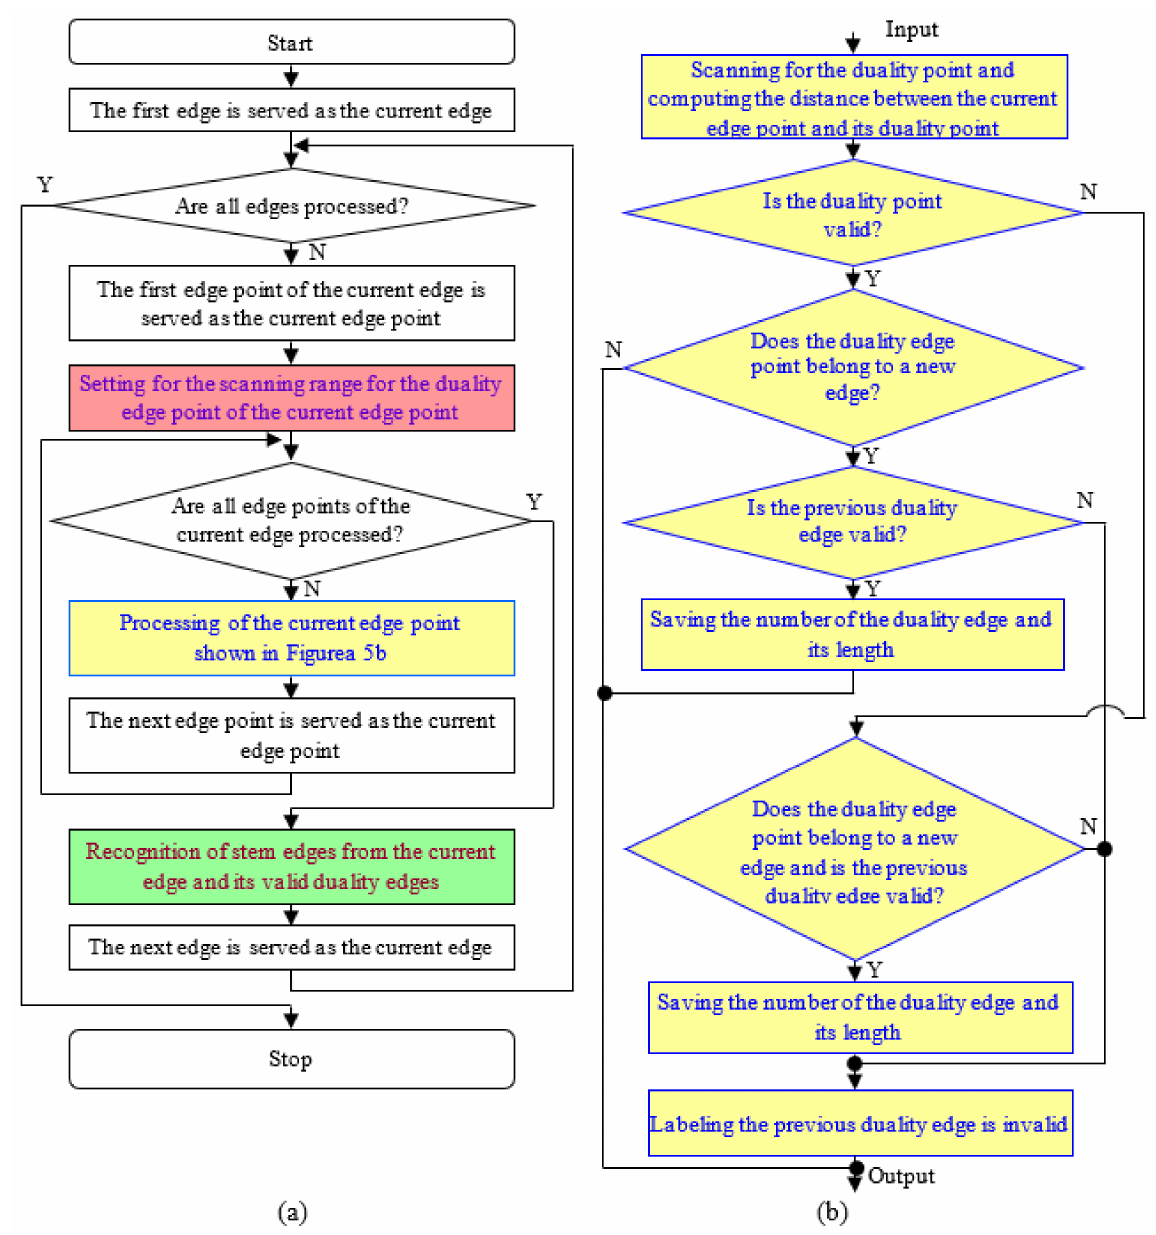
Figure 5. Flowchart of stem duality edge extraction algorithm: ( a ) main flowchart; ( b ) sub-flowchart, processing of the current edge point. Color steps refer to core